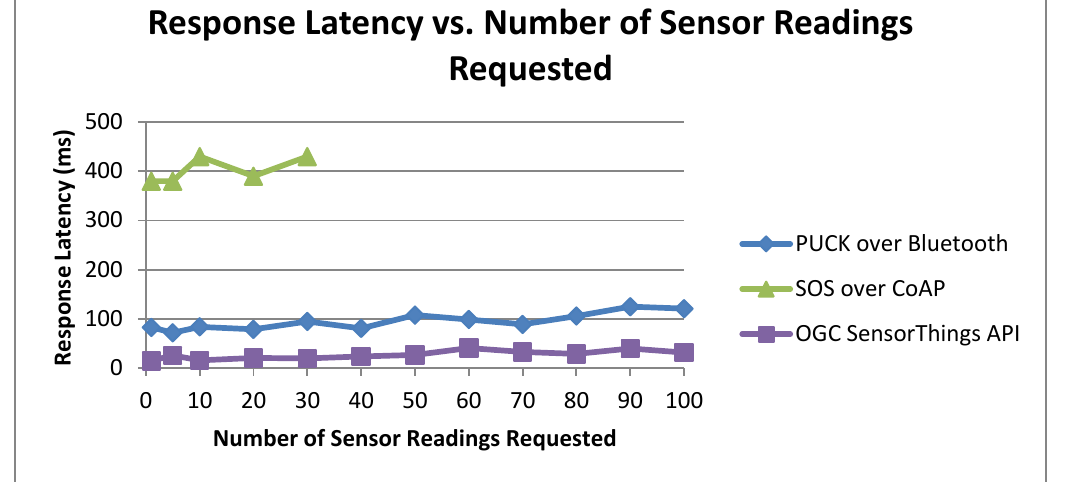
Figure 15. Response latency vs. the number of sensor readings (removed